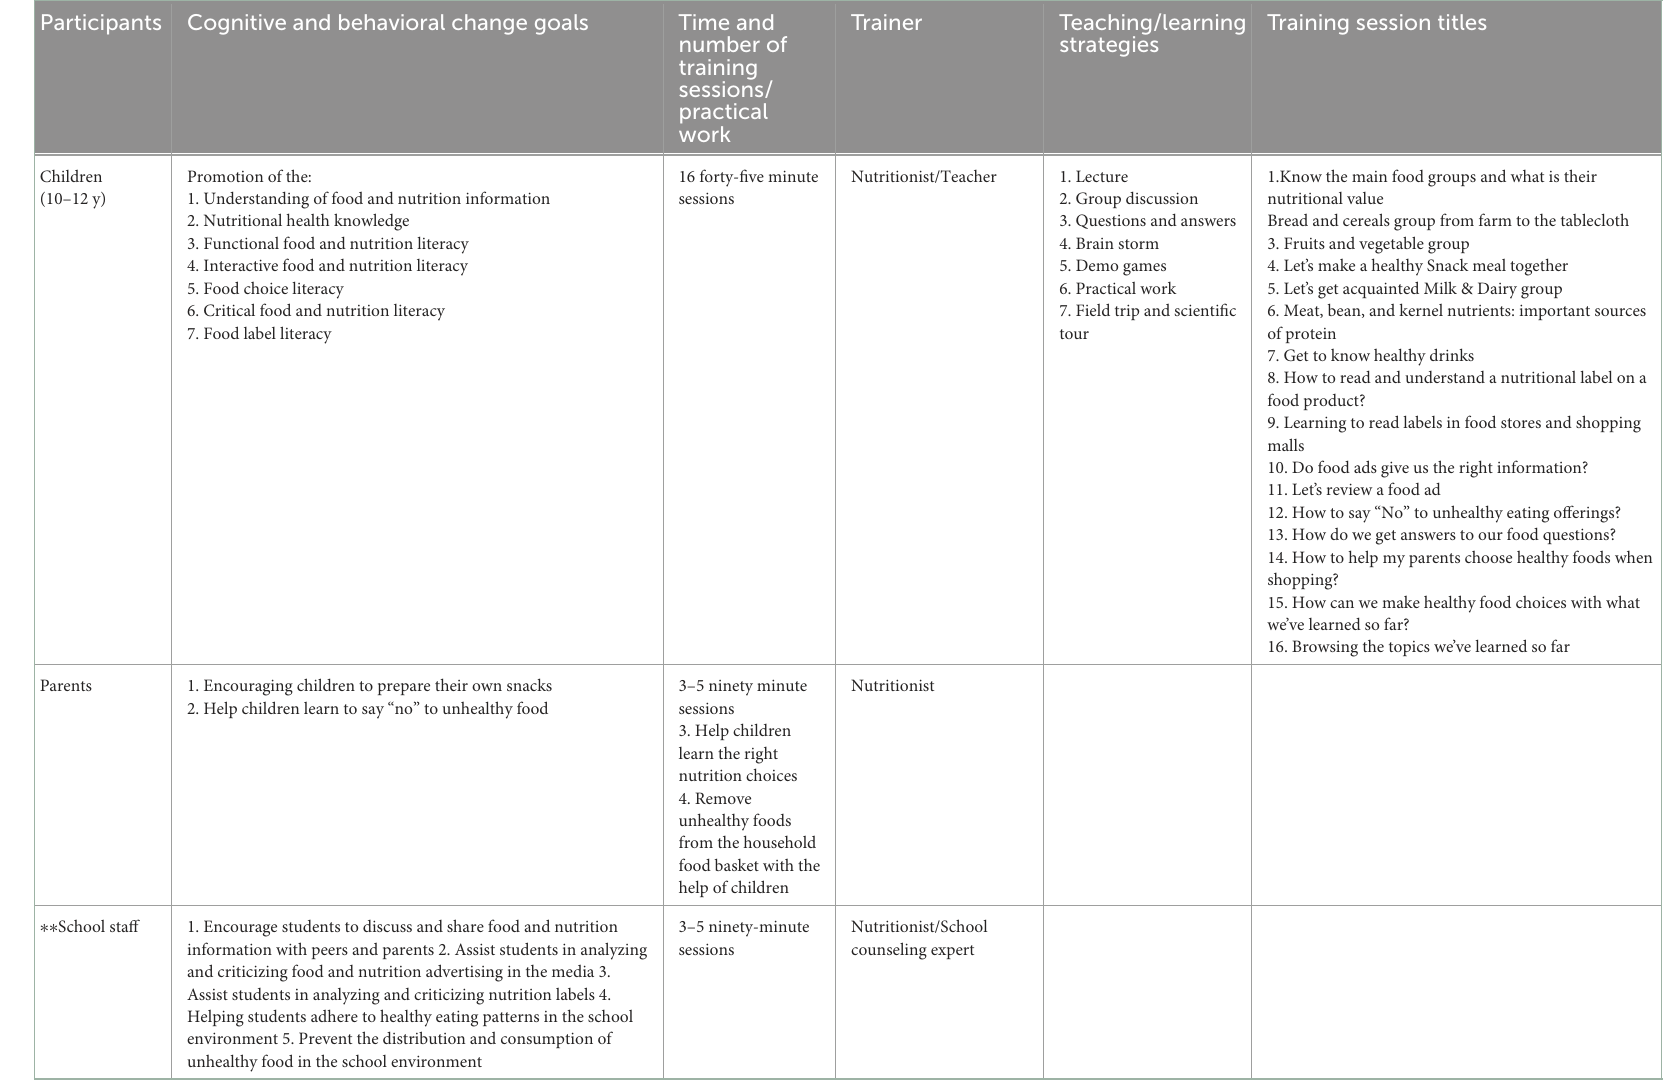
TABLE 1 Educational curriculum for children, parents, and school staff. Participants Cognitive and behavioral change